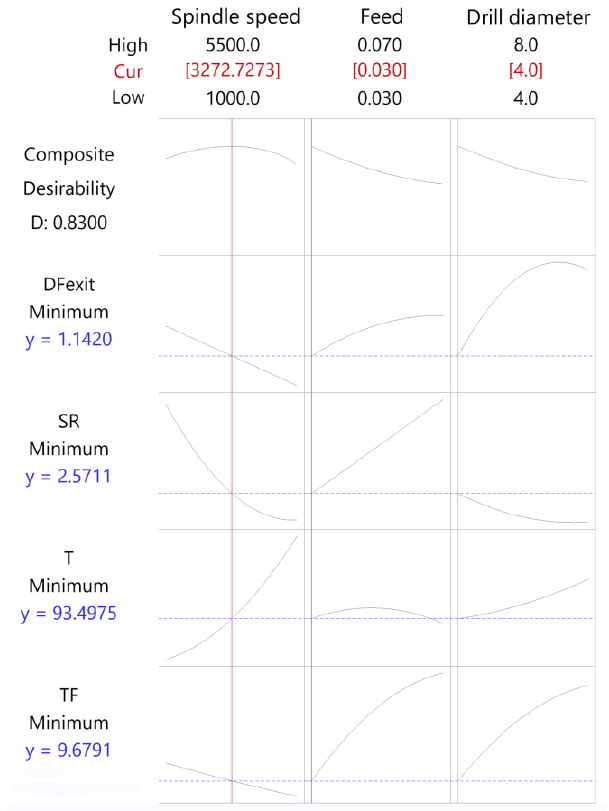
Figure 19. Response optimization desirability plot of neat CEC.